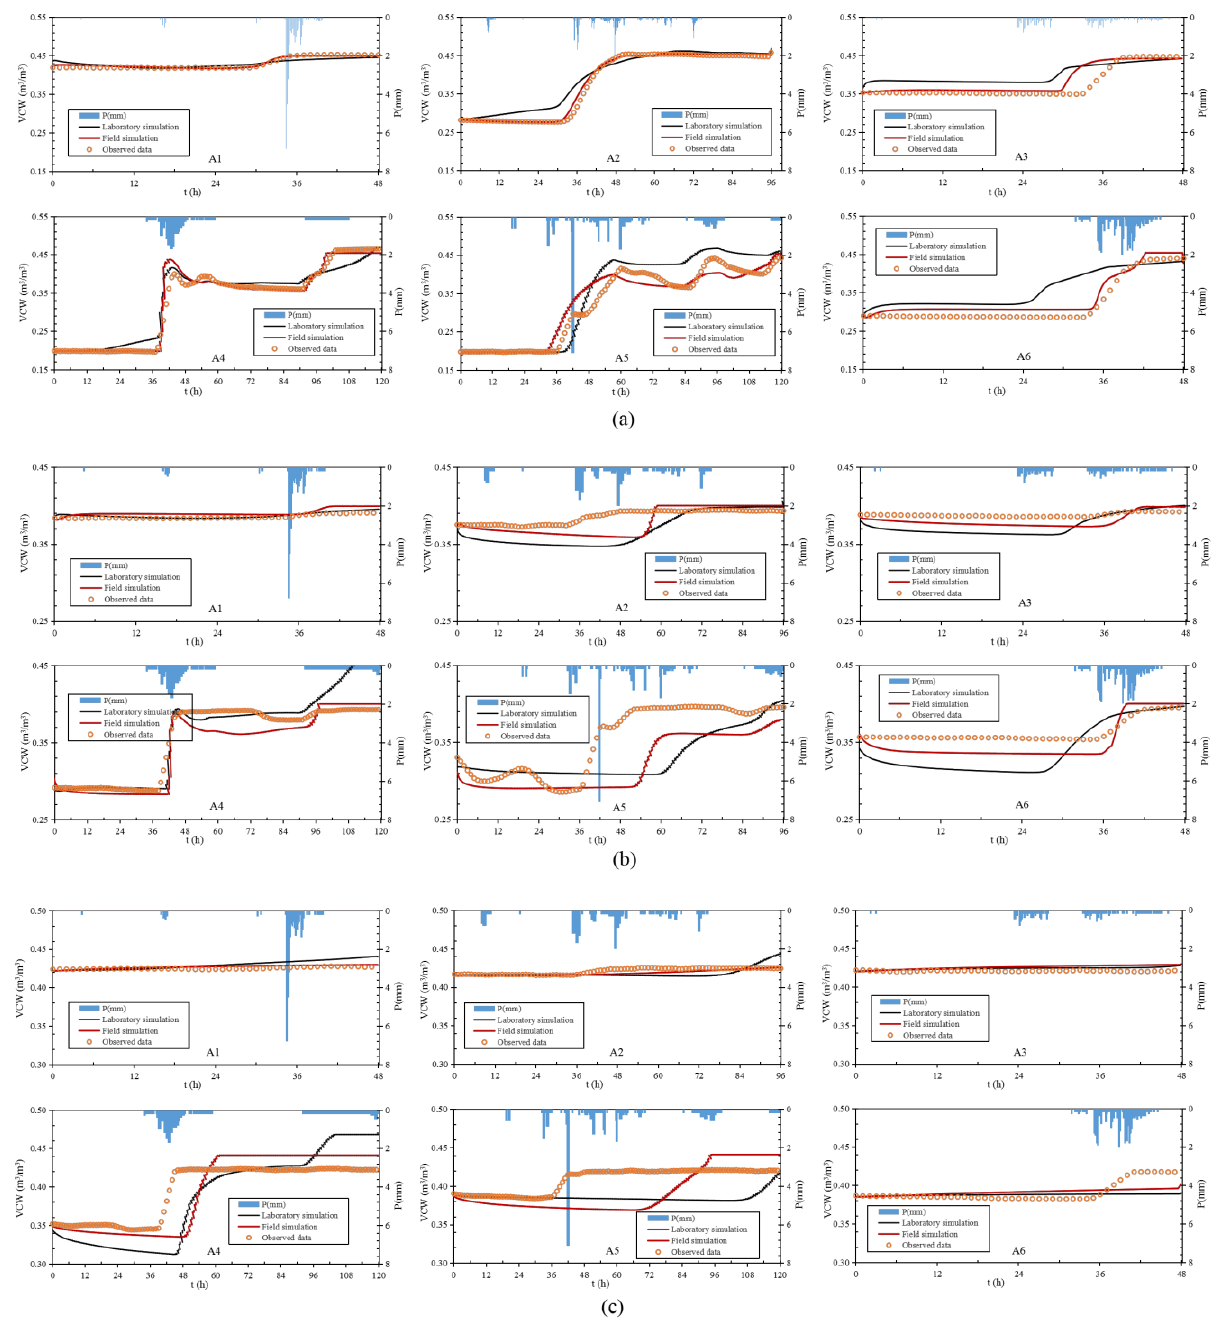
Figure 9. Simulation of soil water dynamics of six precipitation events at ( a ) 10 cm, ( b ) 20 cm, and ( c ) 40 cm depths.